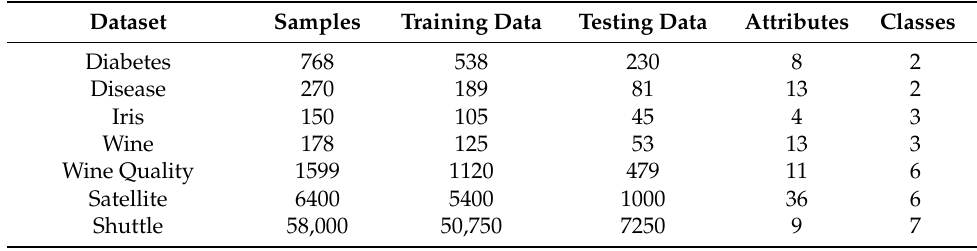
Table 1. Datasets used in the conducted